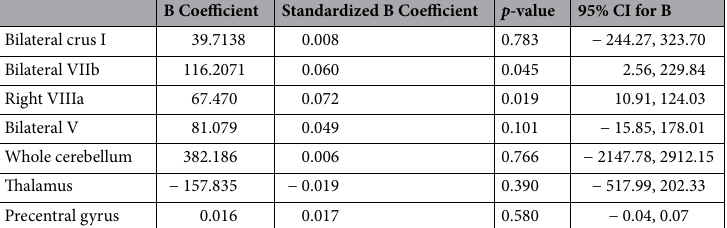
Table 3. Association between gait speed and cerebellar subregion volumes. The thalamus volume and precentral gyrus thickness were measured as control. 95% CI, 95% confidence interval; regression analyses were adjusted for age, sex, education year, and total intracranial